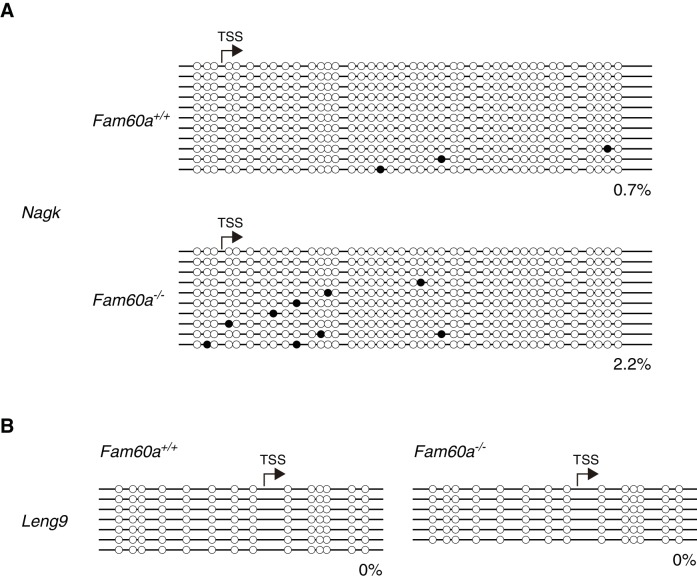
Bisulfite sequencing of Fam60a target gene promoters.The methylation status of Nagk (A) and Leng9 (B) promoters was determined in individual WT and Fam60a–/– embryos at E9.5.